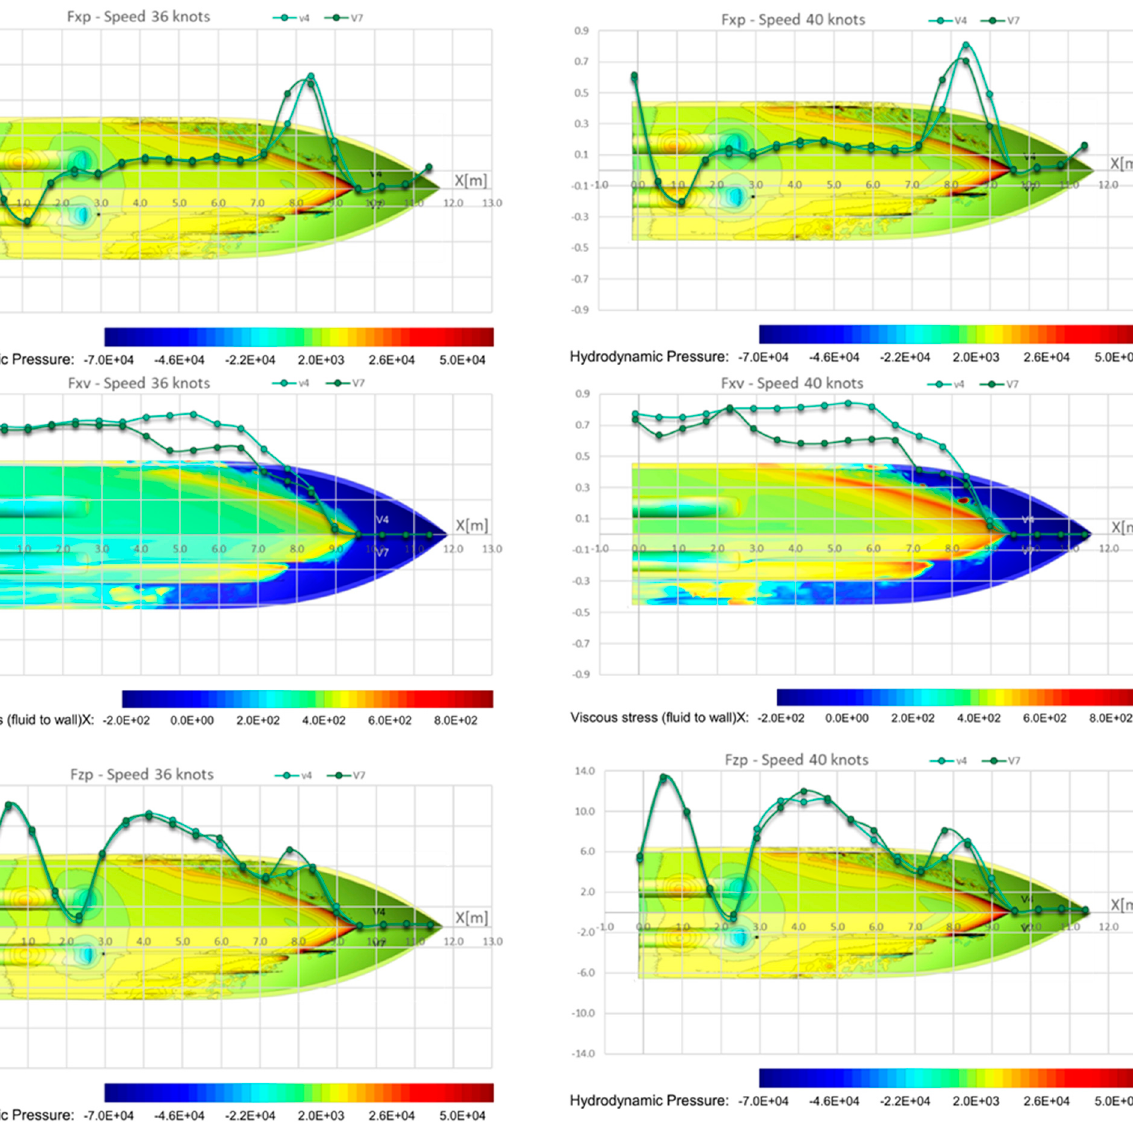
Figure 17. Forces and pressure distributions comparison for V4 and V7, at 36 and 40 kn.